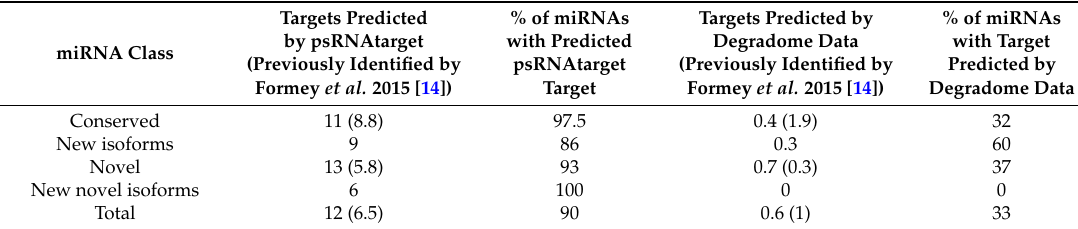
Table 3. Overview of the miRNA target